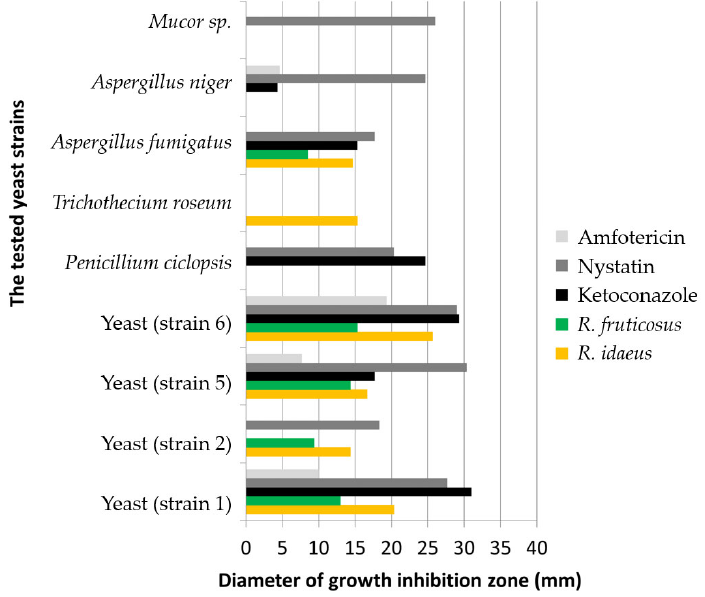
Figure 3. Interaction of P1, P2, and antibiotics with isolated yeast and fungal strains.